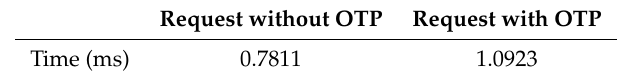
Table 5. Average time for response.